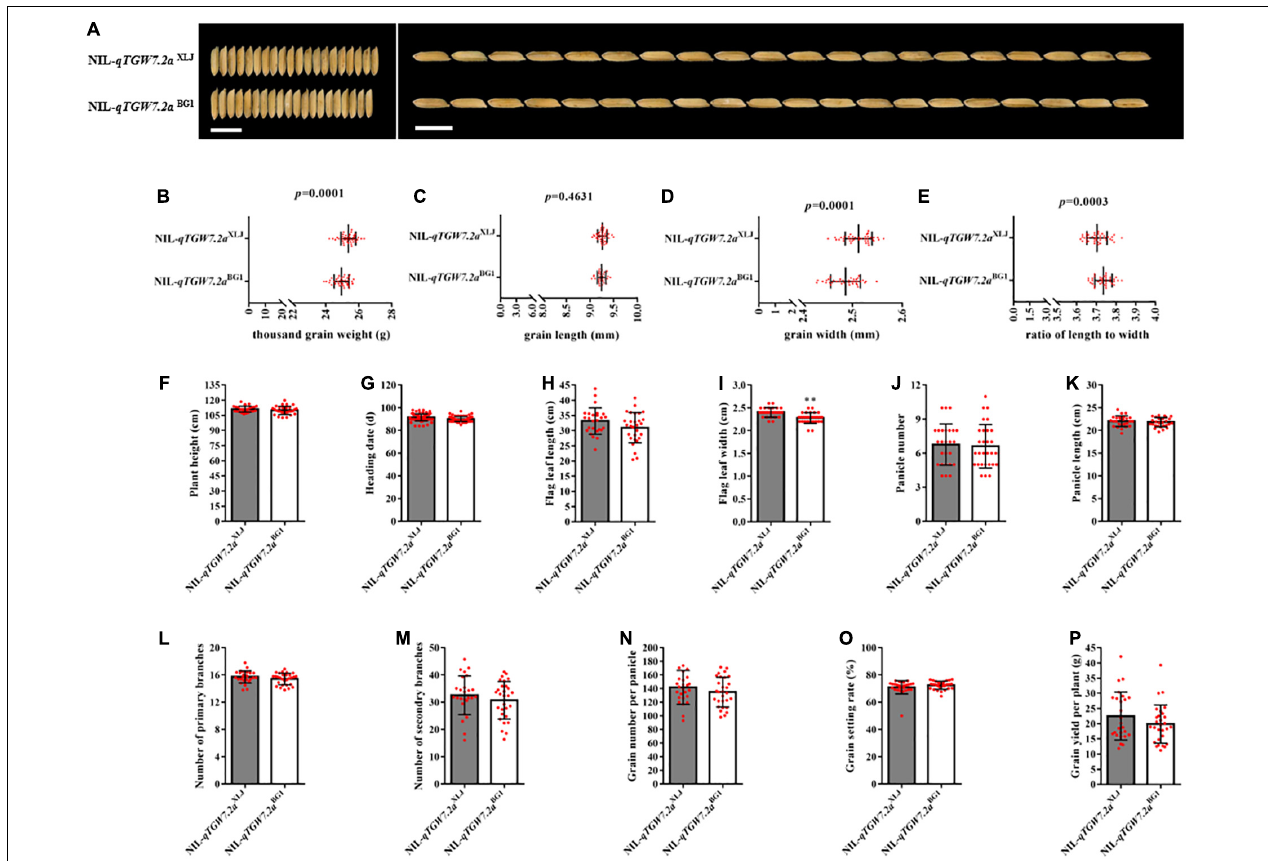
FIGURE 2 | qTGW7.2a regulates grain width and weight. (A) Grain phenotypes of rice NIL plants. Bar = 1 cm. (B) Comparison of thousand grain weight. (C) Comparison of grain length. (D) Comparison of grain width. (E) Comparison of the ratio of grain length to width. (F) Comparison of plant height. (G) Comparison of heading date. (H) Comparison of flag leaf length. (I) Comparison of flag leaf width. (J) Comparison of panicle number. (K) Comparison of panicle length. (L) Comparison of number of primary branches. (M) Comparison of secondary branches. (N) Comparison of grain number per panicle. (O) Comparison of grain setting rate. (P) Comparison of grain yield per plant. Data are given as mean ± SD. Student’s t -test was used to generate P value; ∗∗ P < 0.01; red dot, the number of plants for traits measurement.